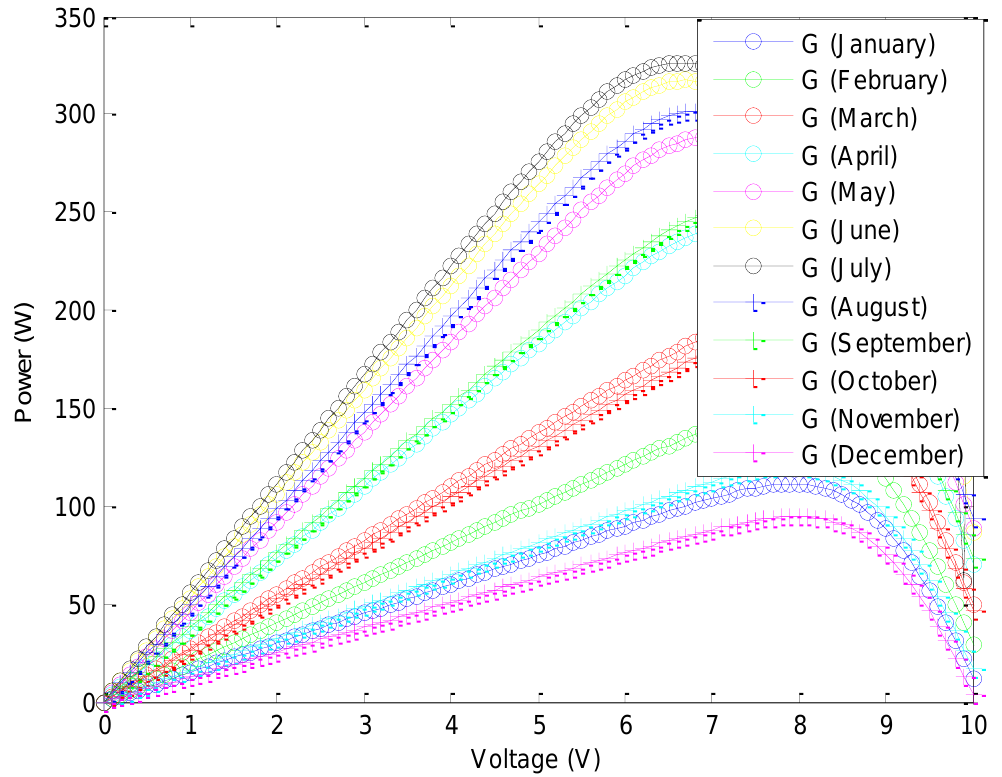
Figure 6. Power-voltage characteristic curves of photovoltaic cells for various irradiation and constant temperature in Tirana,